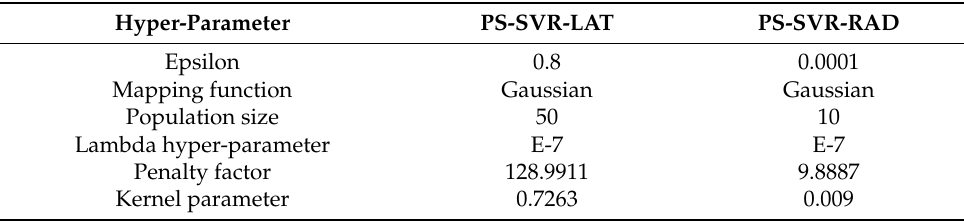
Table 1. Global solutions for support vector regression (SVR) parameters obtained using particle swarm optimization (PSO). (PS = particle sarm, LAT = lattice, RAD =